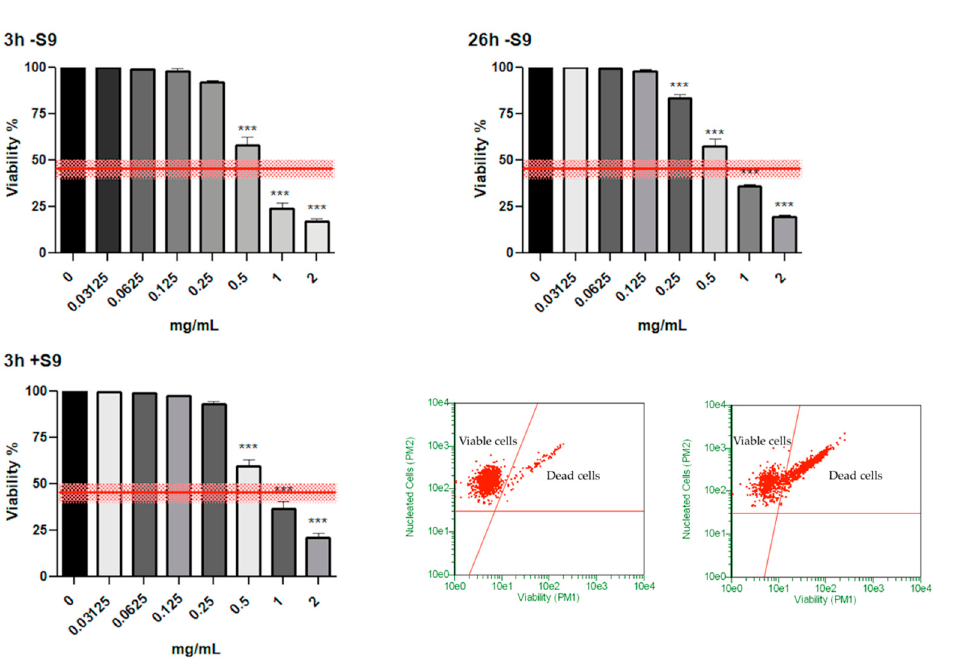
Figure 1. Cell viability on TK6 cells after 3 h − S9 mix, 26 h − S9 mix and 3 h +S9 mix treatment with the SMD at the indicated concentrations compared to the concurrent negative control (0 mg/mL). Each bar represents the mean ± SEM of at least three independent experiments. Data were analysed using repeated ANOVA, followed by Dunnet or Bonferroni post-tests. *** p < 0.001 vs. (0 mg/mL). The red lines in the bar charts represent the OECD threshold for viability (45 ± 5%). Lower right: representative FCM dot plots of viable and dead cells after 26 h S9 mix in culture treated with SMD 0.5 mg/mL (right dot plot) and the concurrent negative control culture (left dot plot).